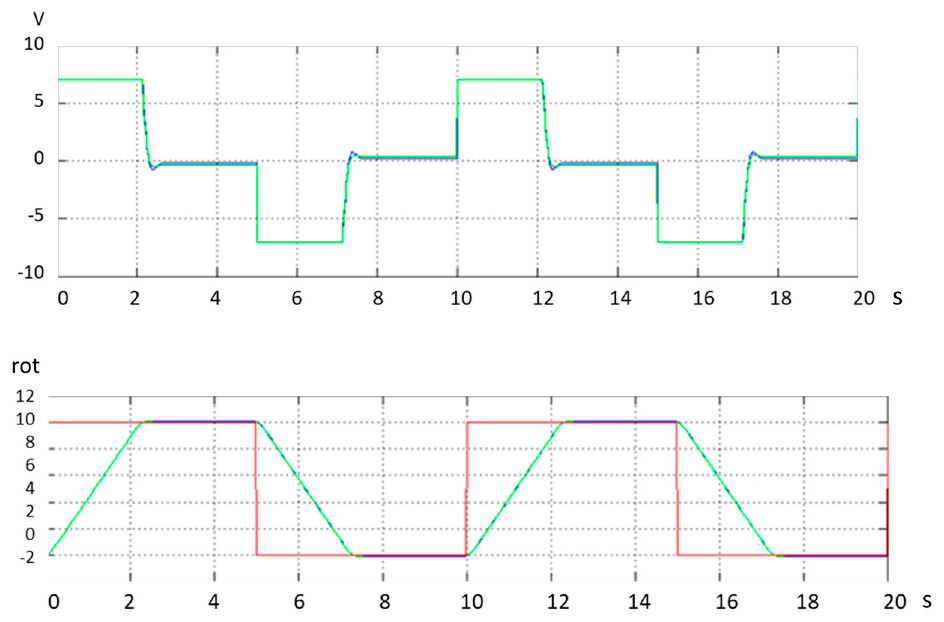
Figure 5. Control system simulation for limit rotations.